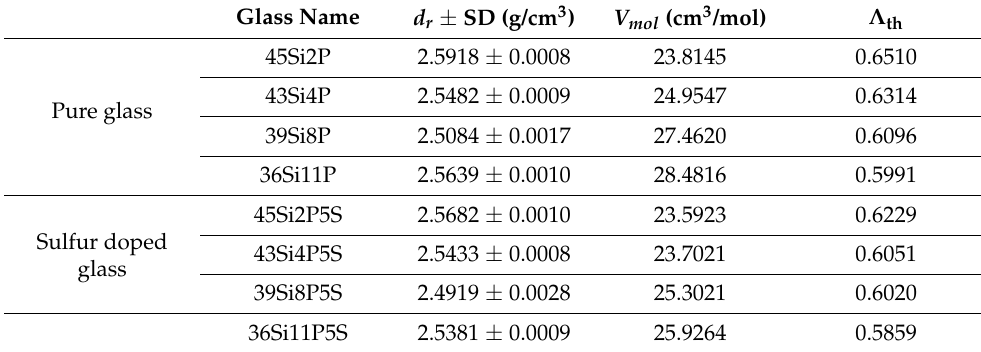
Table 2. The average true density value ( d r ) with its standard deviation (SD), molar volume, and optical basicity ( Λ th ) for the glass samples and glassy crystalline 36Si11P